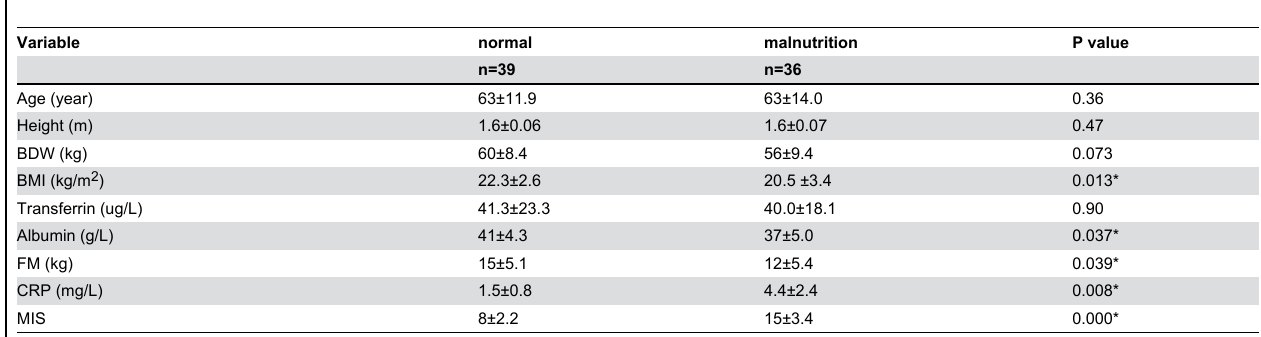
Table 1. Demographic characteristics between two nutrition groups in hemodialysis patients.